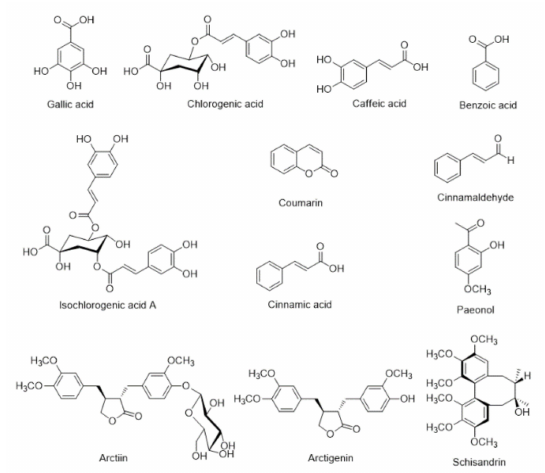
Figure 1. Chemical structures of 12 marker compounds in